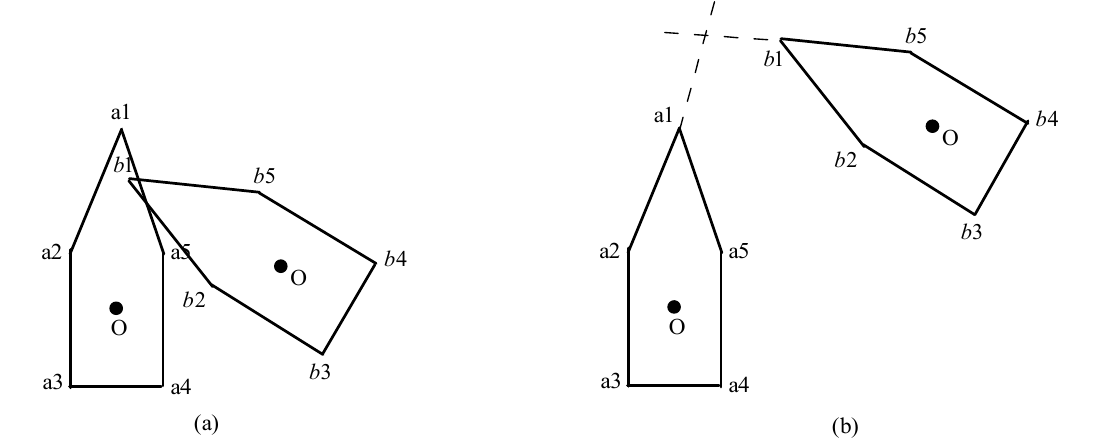
Figure 2. Diagram of collision detection model for aircraft. In case ( a ), the two aircraft collide with each other, and in case ( b ), the two aircraft are both safe.